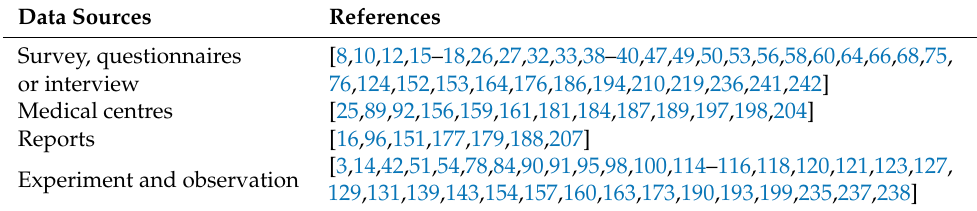
Table 6. References of previous data sources.